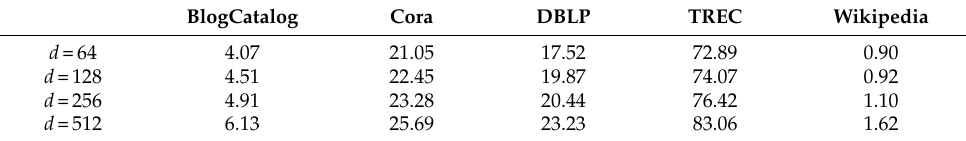
Table 17. Similarity computation time (minutes) with different values of d for all